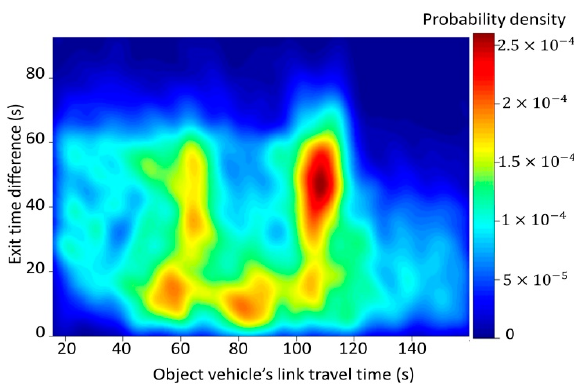
Figure 5. Relationship between object vehicles and crossing vehicles.